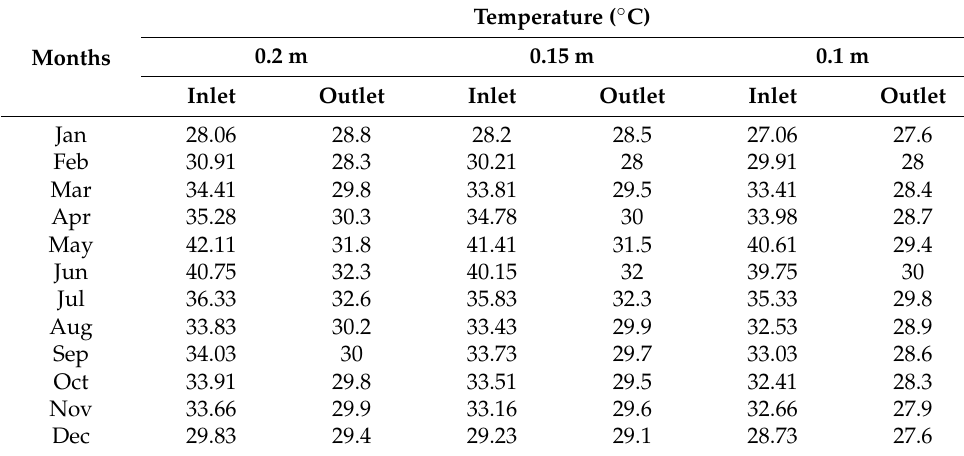
Table 6. The EAHE’s average monthly pipe inlet and outlet ventilation air temperatures for three different pipe diameters.